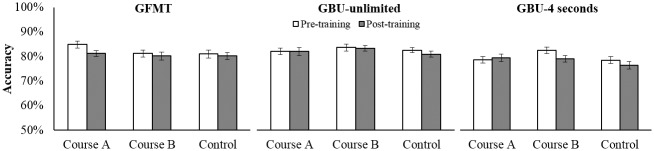
Identification accuracy before and after completing Course A or Course B.Accuracy on the GFMT, GBU-unlimited and GBU-4 seconds tests before (pre-training) and after (post-training) completing online Courses A or B, or the control training. Across all three tests there was no improvement from training. Error bars show within-subjects corrected standard error of the mean [21].